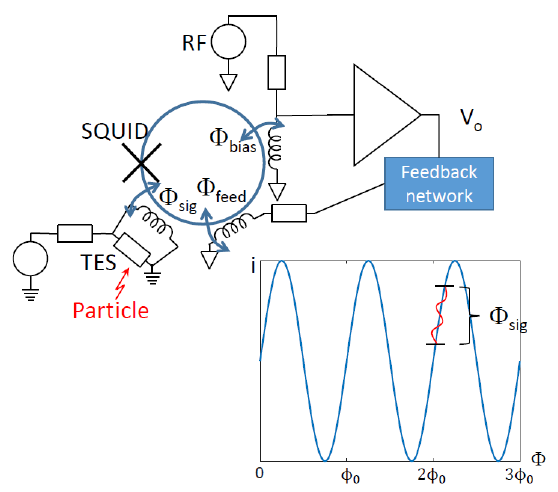
Figure 1. Simplified diagram of a rf-SQUID linked to a TES sensor and read out in closed-loop configuration. The rf-SQUID is the circle with a cross that represents the Josephson tunnelling junction, coupled to 3 inductors: The rf-bias and reading node, the feedback, and the signal inductors. The diagram represents (1). Φ feed = − Φ sig , and the output voltage is proportional to Φ sig